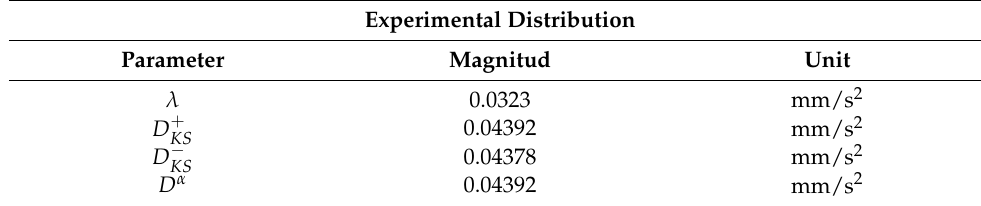
Table 1. Hypothesis test result.